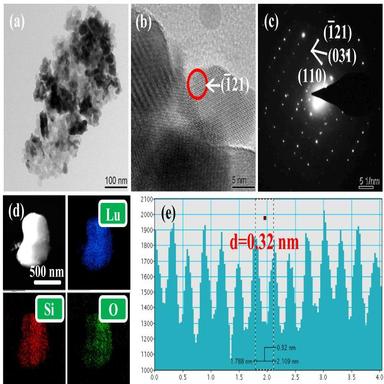
TEM analysis of the X2-Lu2SiO5 feedstocks (a) TEM, (b) HRTEM, (c) SAED, (d) Mapping and (e) d value in (b).